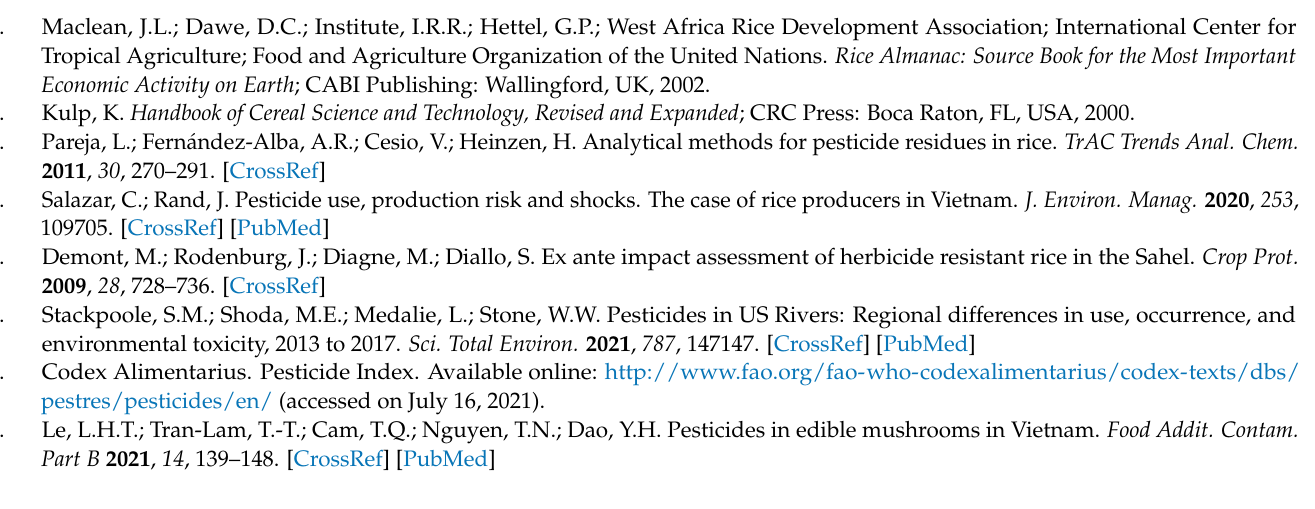
MS/MS, Table S2: List of pesticides, method parameters and results of validation parameters: linearity range, matrix effect, limit of detection, limit of quantitation, recovery and reproducibility of UPLC-MS/MS method, Table S3: PTV injection conditions; Table S4: List of pesticides, method parameters and results of validation parameters: linearity range, matrix effect, limit of